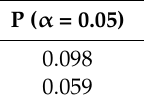
Figure 5. Response surface derived from the combination of the β -glucan concentration and the percentage of inoculum over free amino groups amount during milk fermentation by L. rhamnosus GG. According to the experimental design, the optimal growth value of L. rhamnosus GG (1.04 × 10 10 CFU/mL) is reached with 22.46 g/L of β -glucan and 4.38% of inoculum and the optimal concentration of free amino groups (0.33 mg/L) using 22.71 g/L of β -glucan combined with 4.18% of inoculum. Three confirmatory experiments were carried out under the optimal conditions. Comparison between the results of the confirmatory experiments and those predicted by the model showed no significant differences (Table 3). Table 3. Predicted and experimental values of the